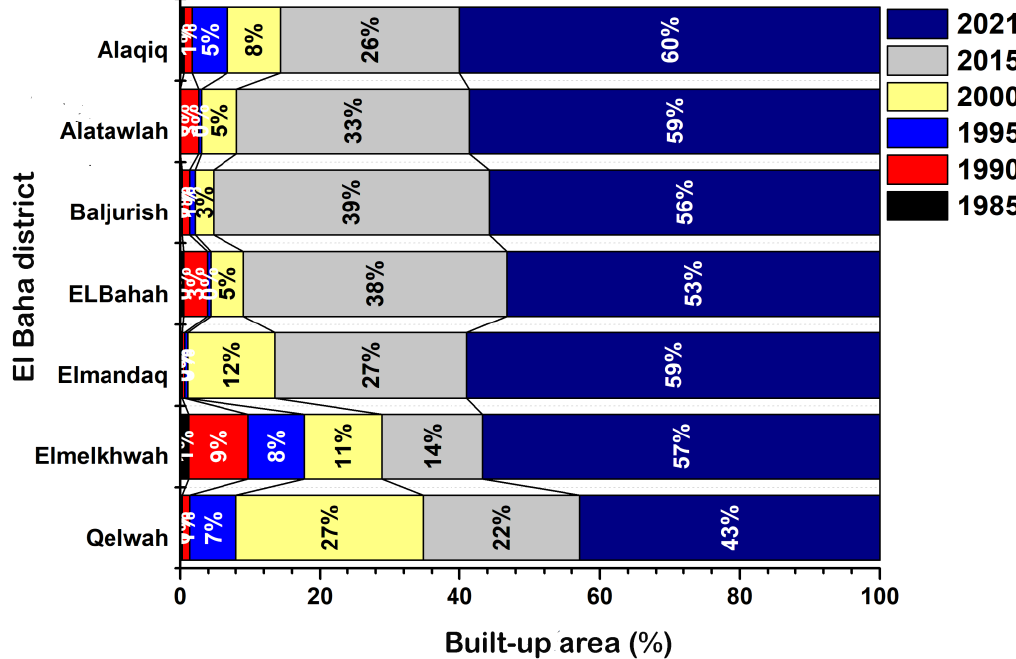
Figure 7. Change in built-up area (km 2 ) for the years: 1985, 1990, 1995, 2000, 2015, and 2021.